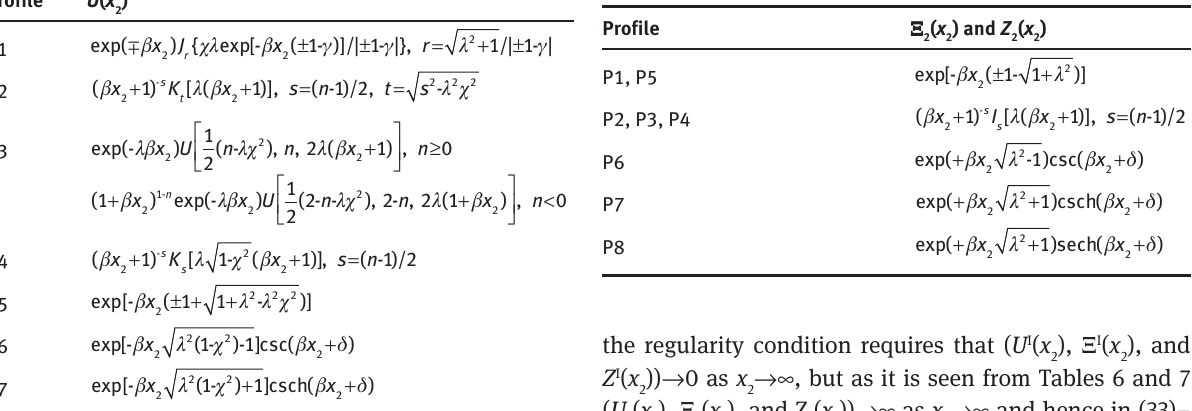
Table 4: Solution of U